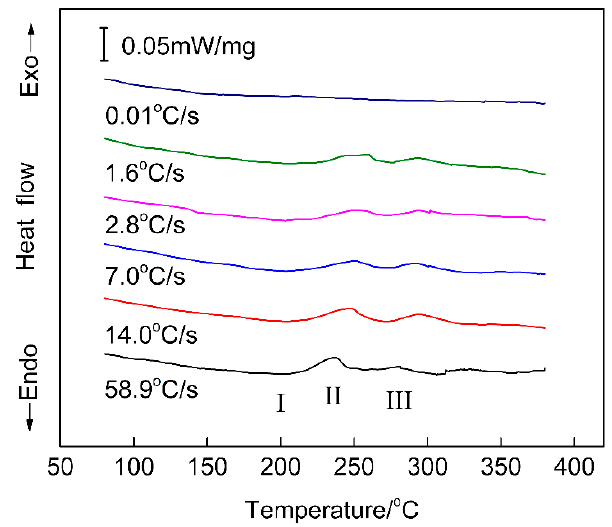
Figure 14. Differential scanning calorimetry (DSC) curves for samples with different quenching Figure 14. Di ff erential scanning calorimetry (DSC) curves for samples with di ff erent quenching rates.